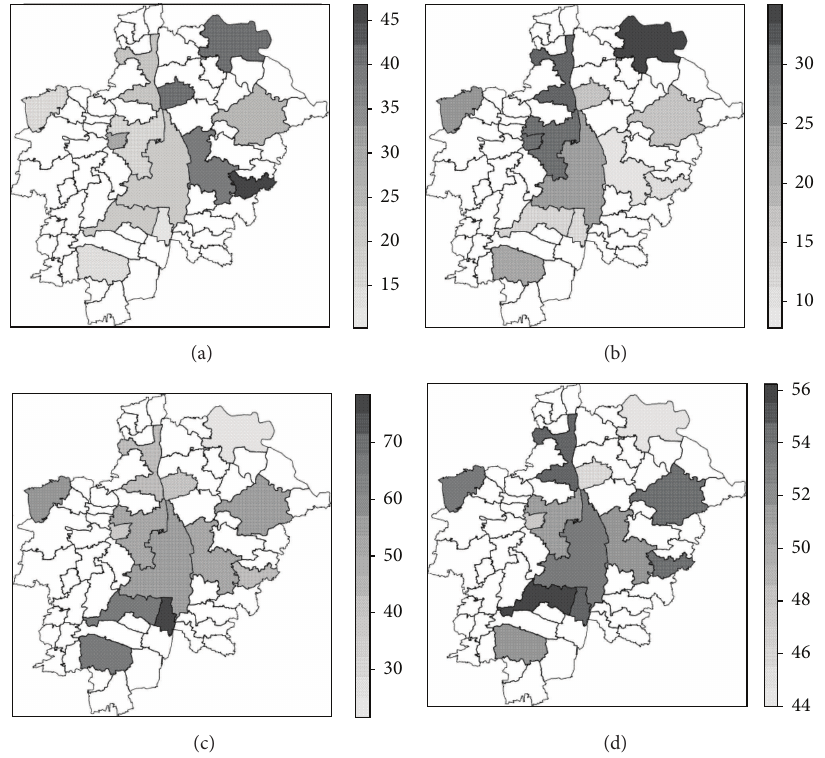
Figure 3: Values of age-related parameters; values refer only to German native subjects. (a) Percentage of subjects in the age category: 25–39 years (AGE25 39); (b) percentage of subjects in the age category: 40–54 years (AGE40 54); (c) percentage of subjects in the age category: